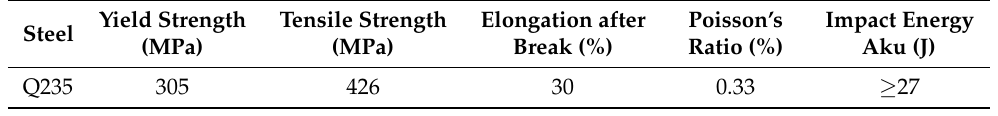
Figure 1. Structures of UHMW-PE composite armors. ( a ) Armor with two layers of PE. ( b ) Armor with three layers of PE. with three layers of PE. Table 1. Material properties of Q235 Table 1. Material properties of Q235 steel.